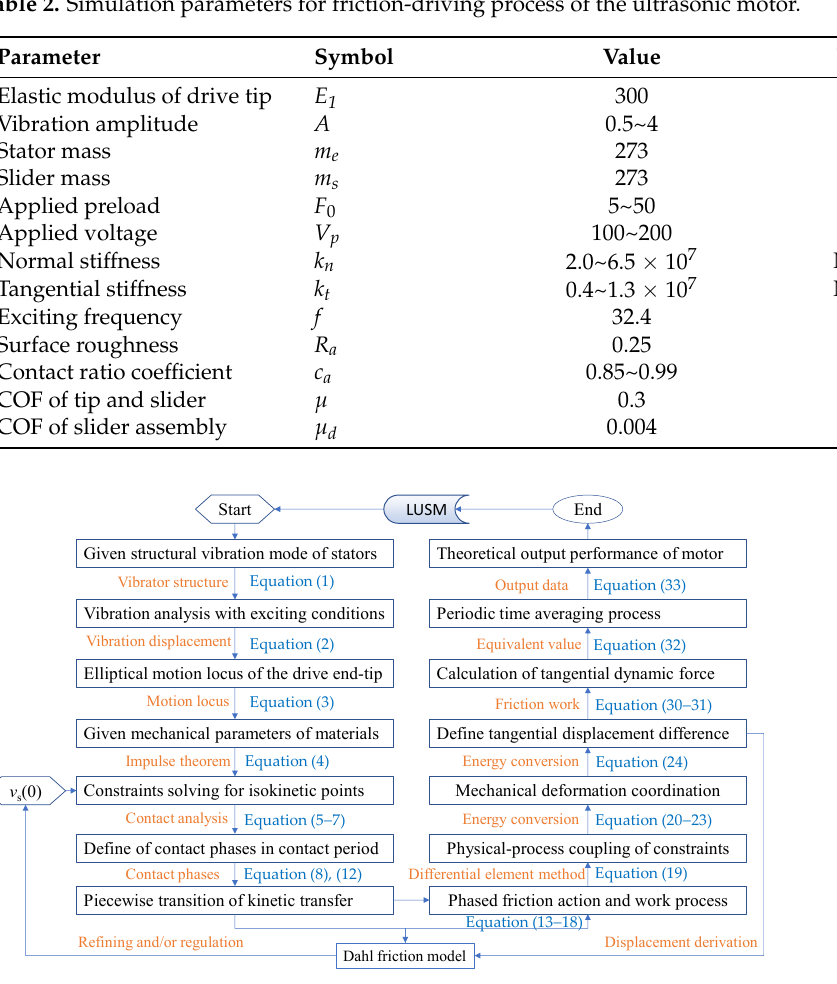
Figure 8. Calculating flowchart of Dahl friction model for ultrasonic motors in this study.